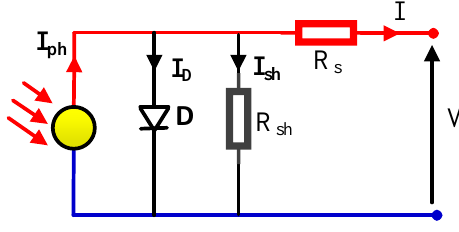
Figure 1. Equivalent circuit of SDM.